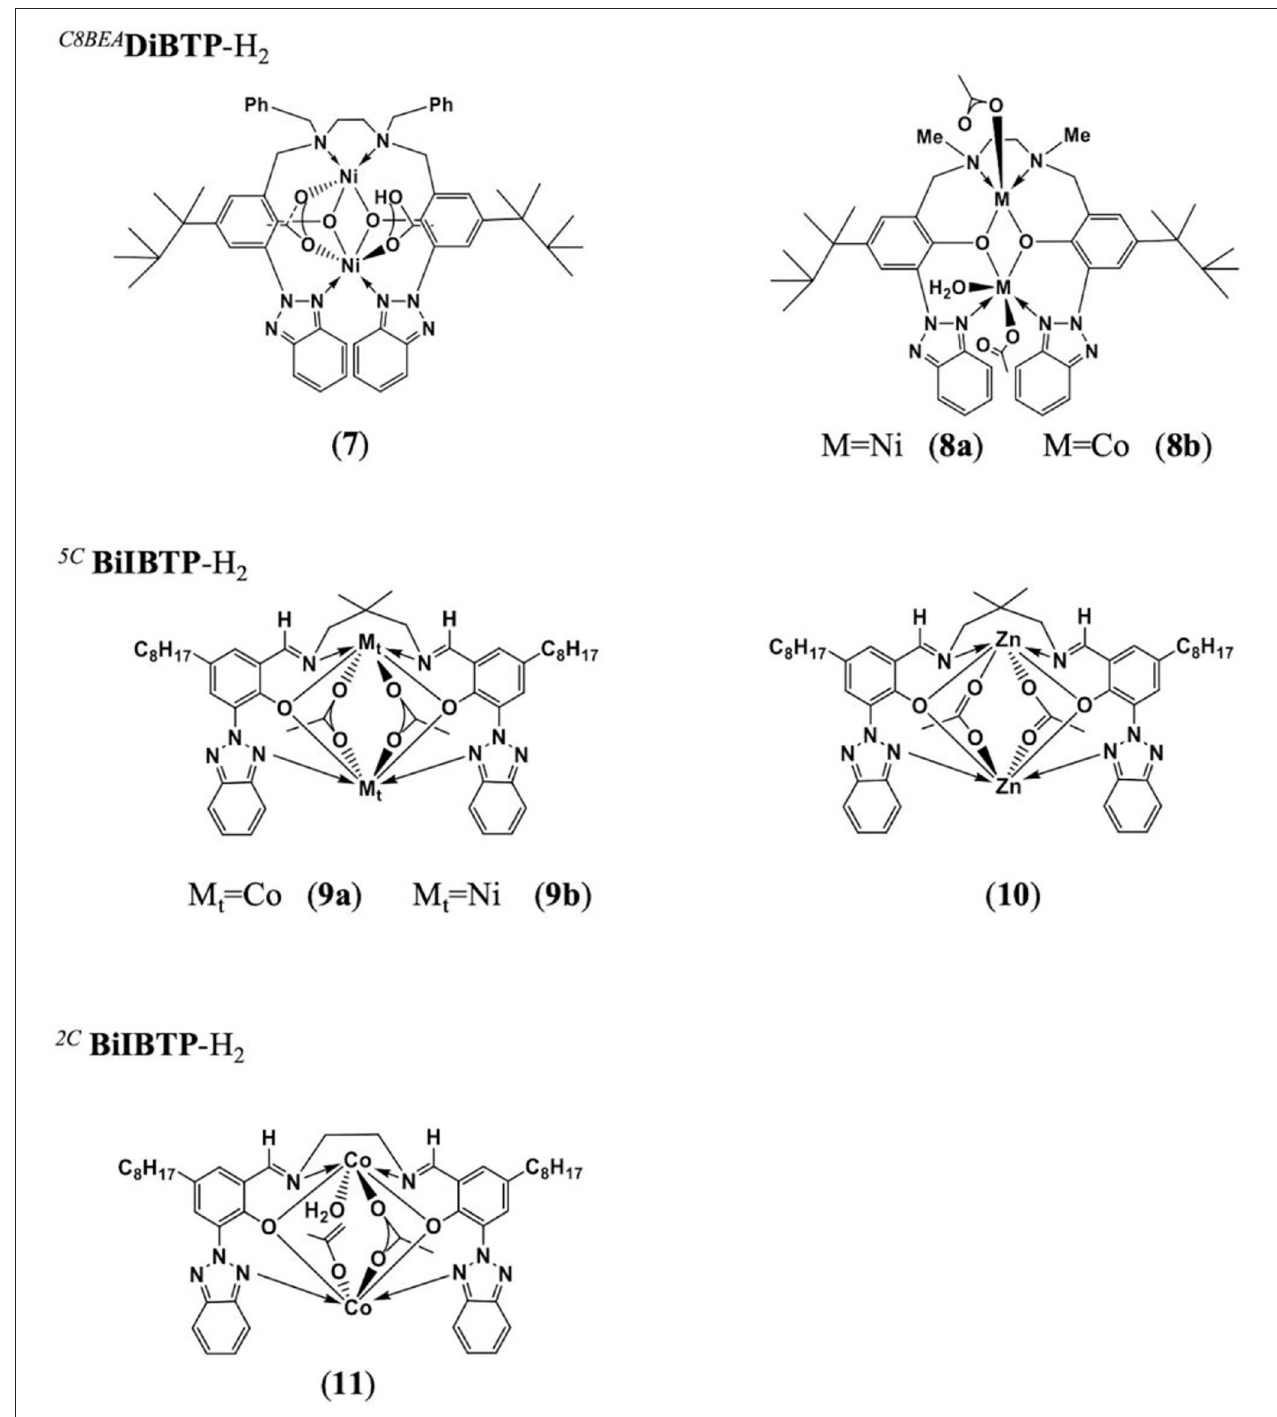
FIGURE 6 | The structures of catalysts 7–8 or 9–11 based on DiBTP-H 2 or BiIBTP-H 2 , respectively.